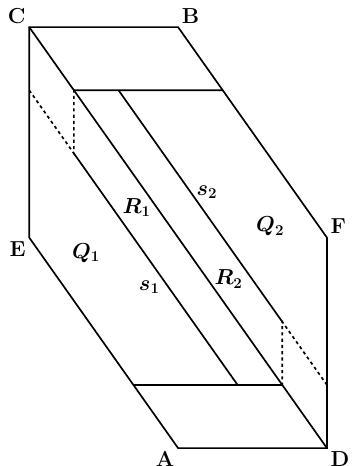
Figure 4. The faces AECD and BCDF of the sticking region H , where seismic events start, and their subsets ( α = 1, β = 1, γ = 1, (cid:15) = 0 . 7). The events taking place on the face AECD (BCDF) start with mode 10 (01). The trapezoids Q i correspond to events involv- ing a single asperity; the segments s i correspond to events associ- ated with the consecutive slips of the asperities; the trapezoids R i correspond to events involving the simultaneous slips of the asperi-